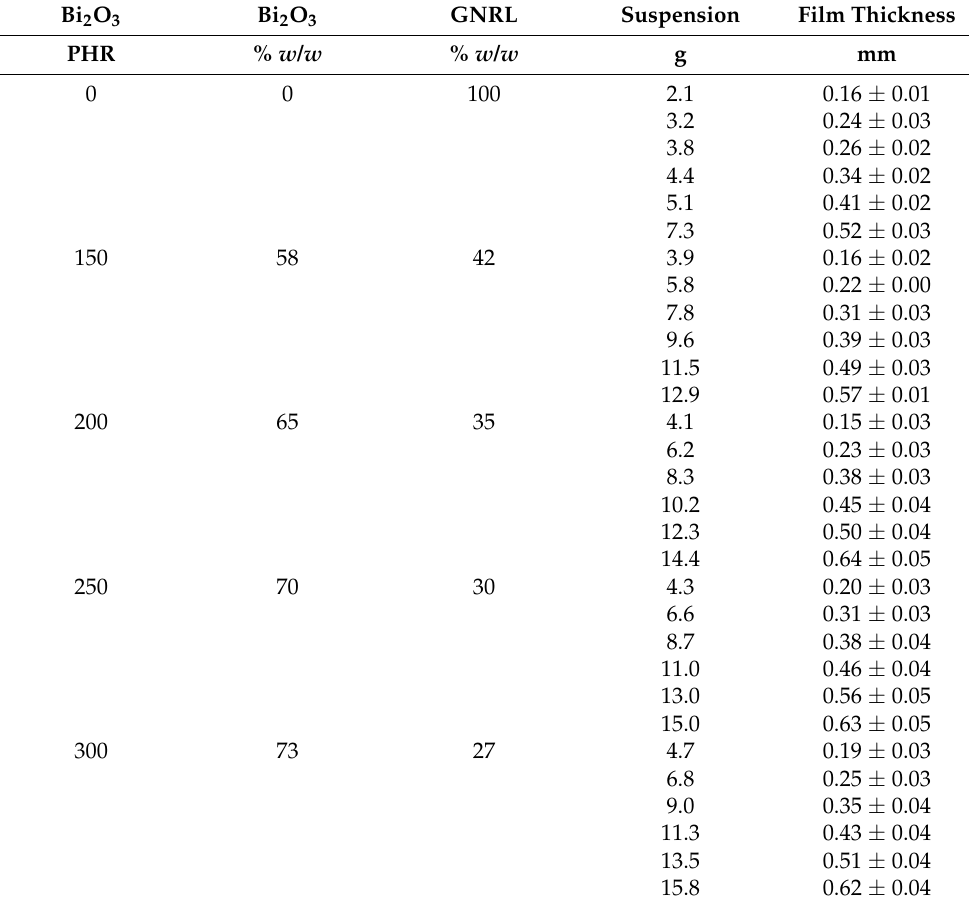
Table 3. Prepared GNRL/Bi 2 O 3 films by casting with different weight fractions (wt %) of attenuating filler and GNRL, amount of suspension added to the Petri dishes, and film thickness.